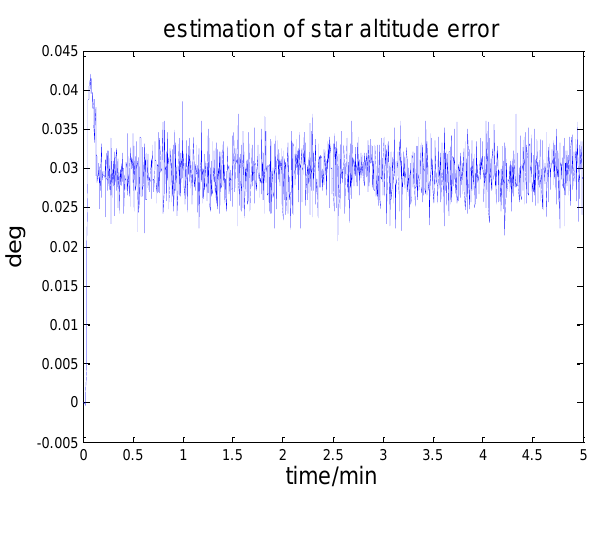
Figure 10. The estimation of star altitude